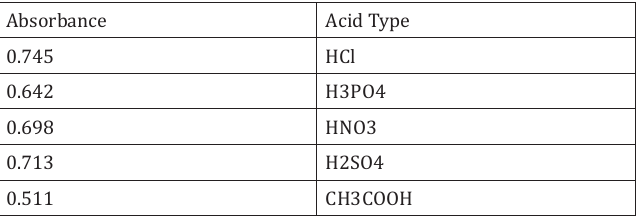
Acid type effect on the absorbance level